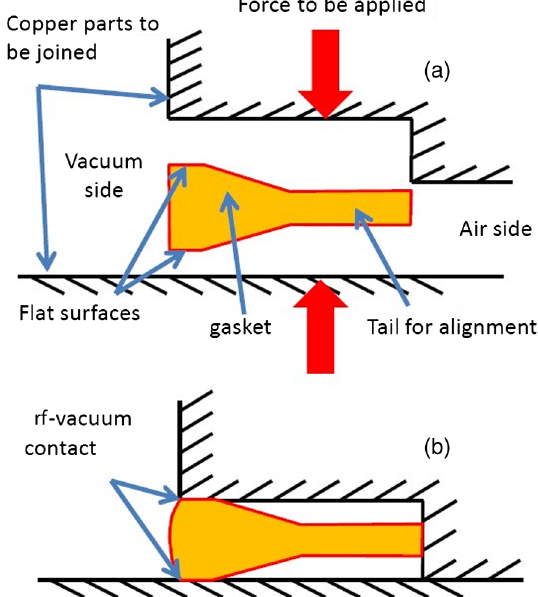
FIG. 12. Geometry of the gasket and mechanism of gasket compression: (a) uncompressed gasket; (b) compressed gasket.